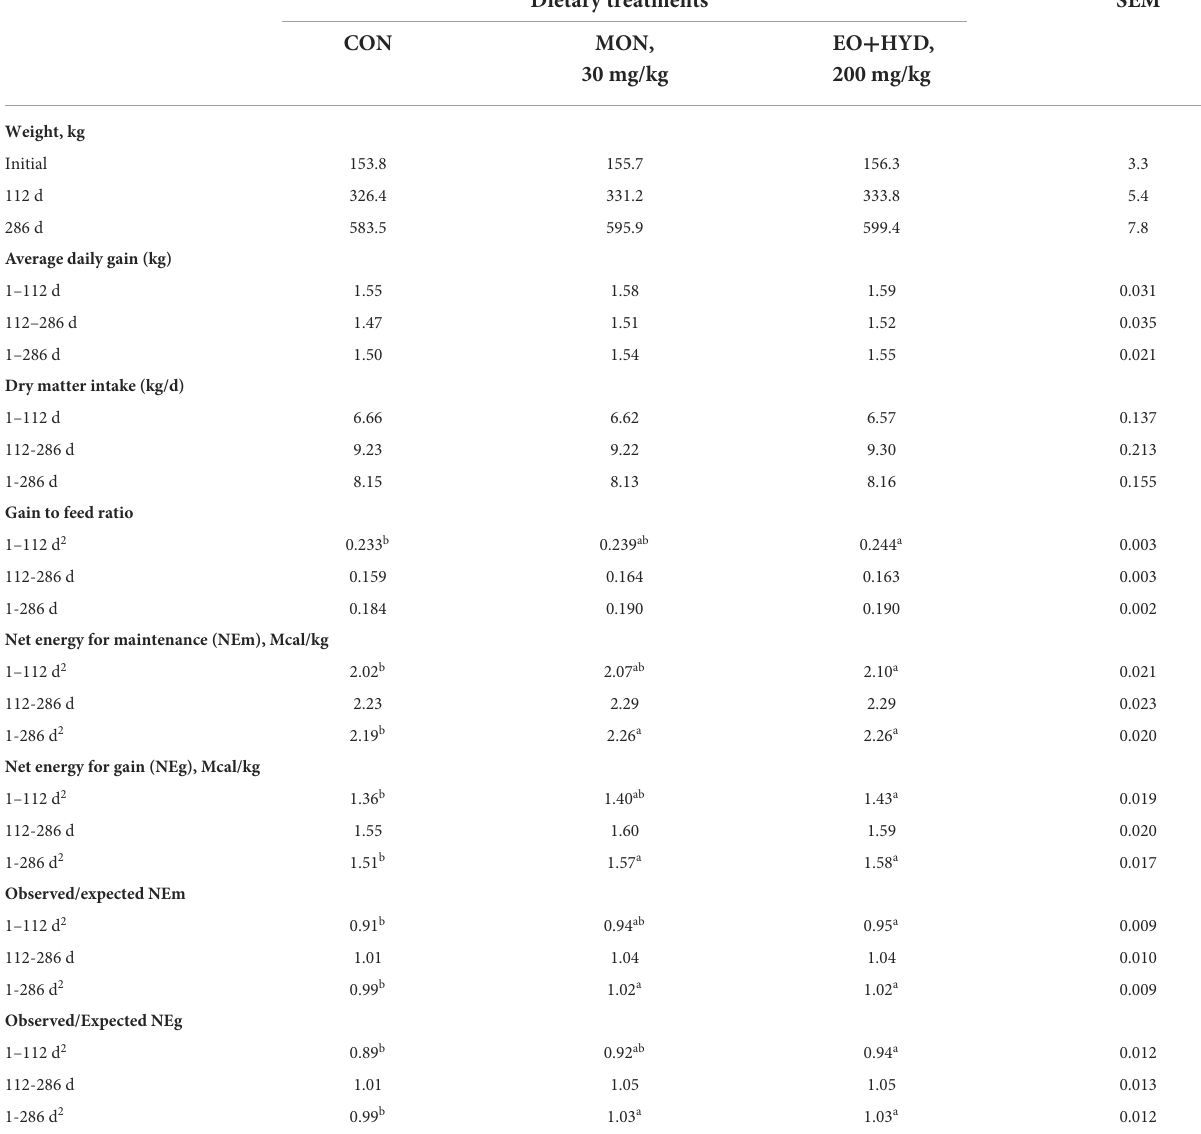
TABLE 2 Influence of feeding an eubiotic blend of essential oils plus 25-hydroxy-vit-D3 on growth-performance of calf-fed Holstein steers. Dietary treatments 1 SEM CON MON, EO + HYD, 30 mg/kg 200